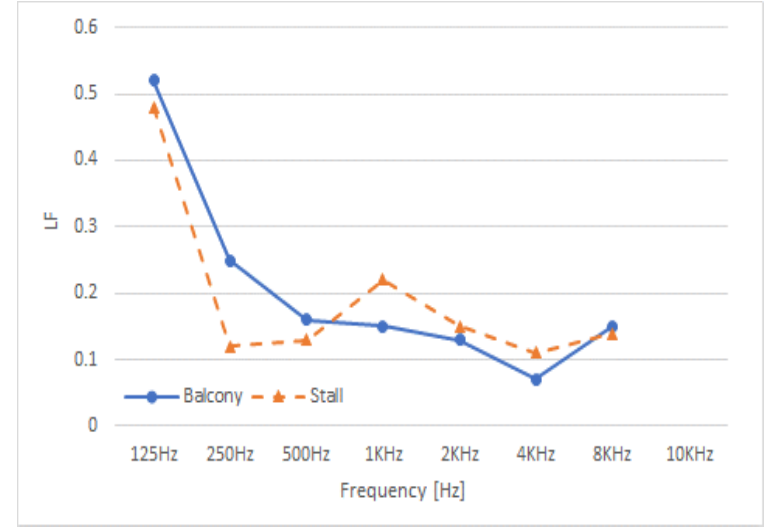
Figure 12. Measurements results of the Lateral Fraction (LF).